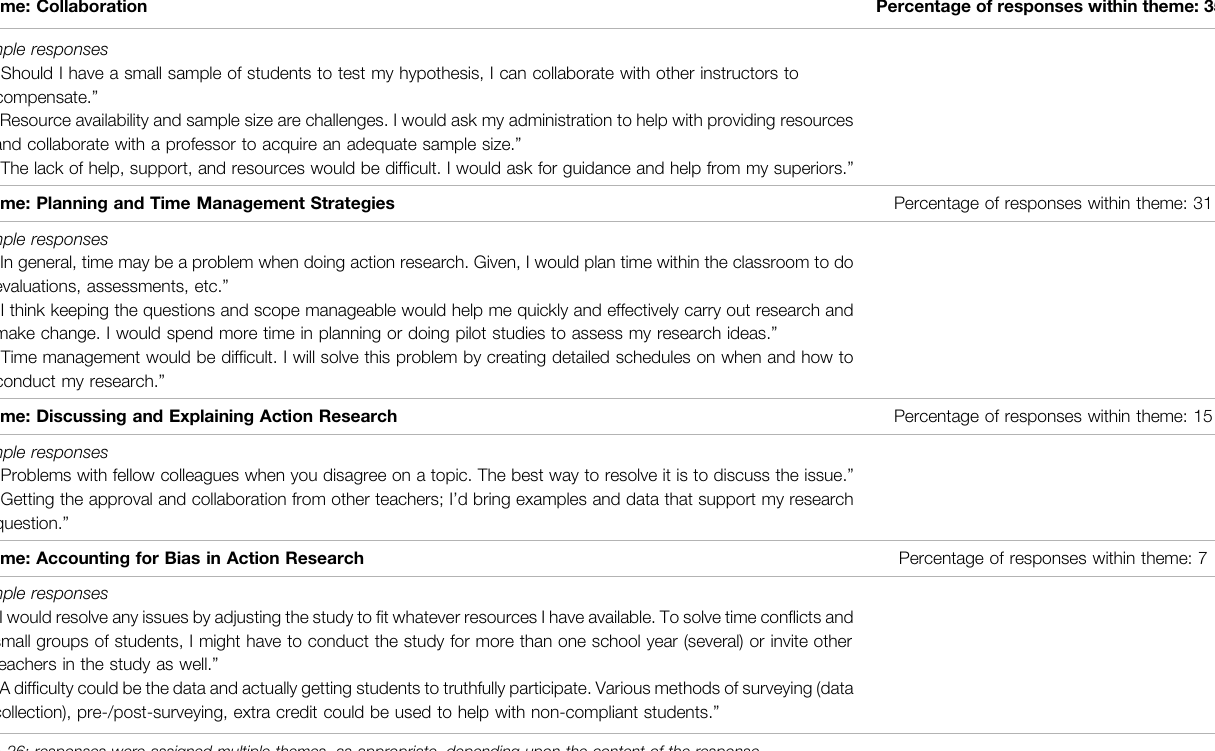
TABLE 7 | Emergent themes from participants ’ responses when asked the question: “ What potential problems/dif fi culties would you anticipate encountering if you were to engage in action research, and how would you resolve them? Theme: Collaboration Percentage of responses within theme: 35